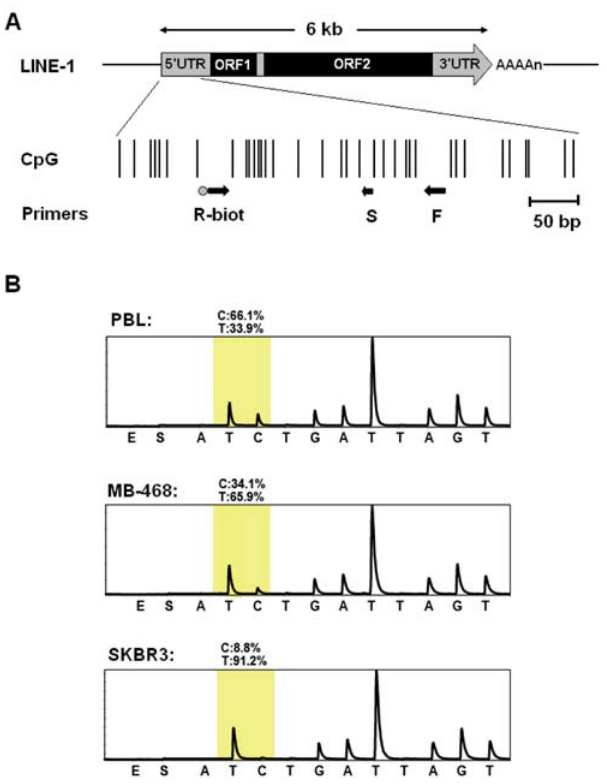
Figure 1. Quantitation of DNA methylation using bisulfite LINE-1 PCR and pyrosequencing. A) Diagram of the CpG island promoter (GenBank accession no. X58075, nucleotide position 108–520 bp) associated with the full length LINE-1. Each vertical line represents a single CpG site. The 3 9 UTR, 5 9 UTR and two ORFs of LINE-1 are shown at the top. Arrows indicate the location of primers used for bisulfite PCR (R-biot and F) and